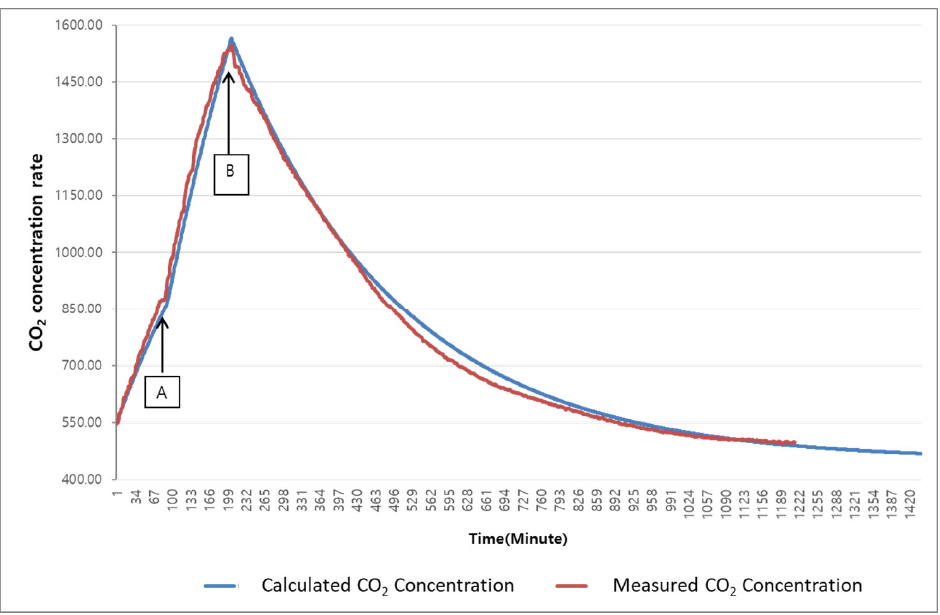
Figure 15. Comparison of the CO 2 emission results.